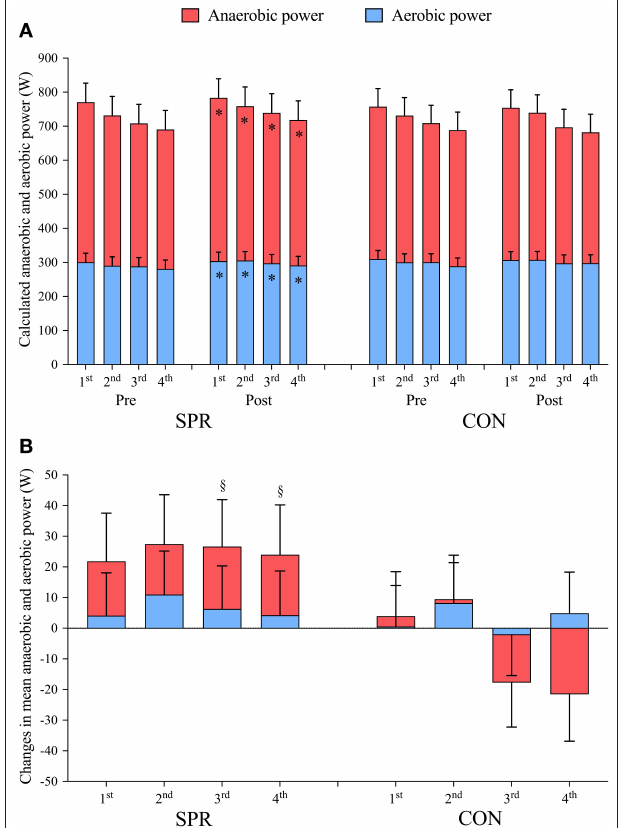
0.001, ES: 0.6), and from the first to the third sprint (37.6 ± 1.5%, p = 0.001, ES: 0.4). FIGURE 3 | (A) Calculated mean anaerobic and aerobic power output during